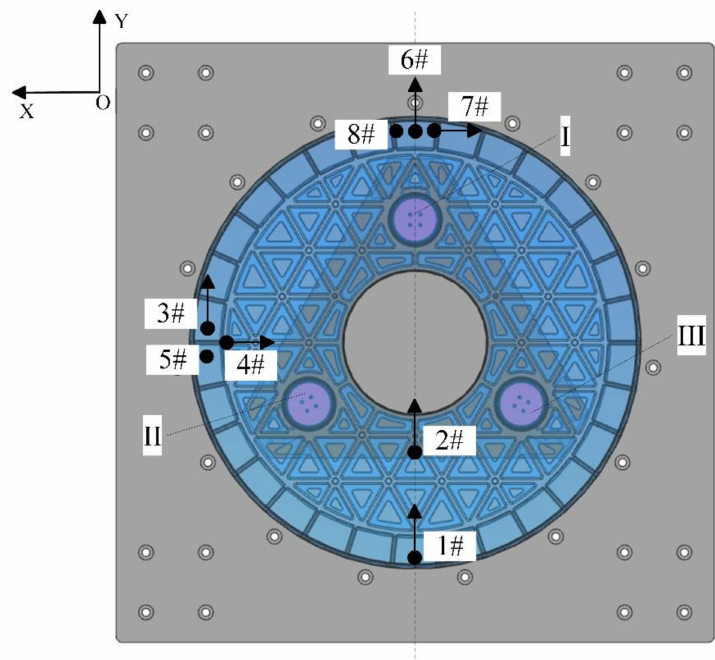
Figure 15. Sensor bonding position.